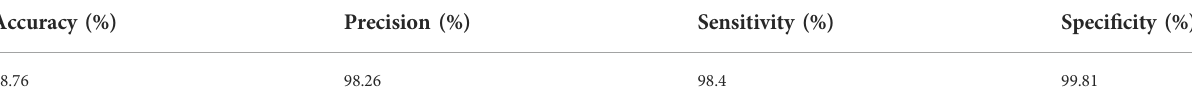
TABLE 4 Results of the third experiment.